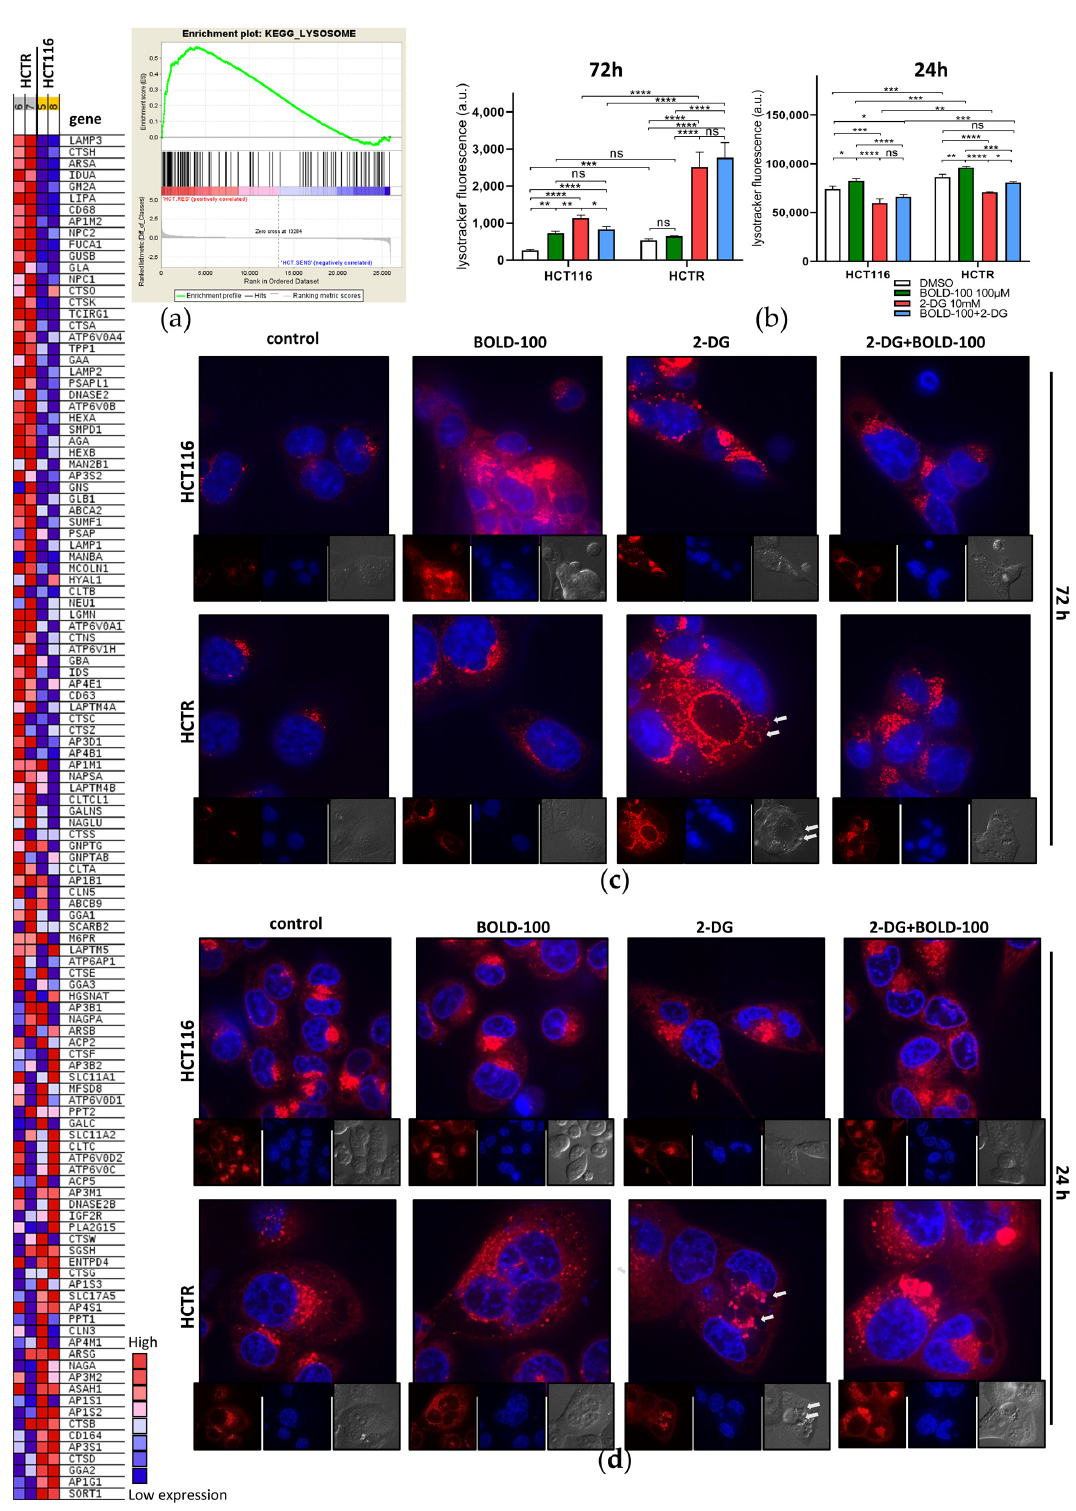
Figure 5. Survival and death from glucose deprivation by 2-DG is associated with differential regulation of the lysosomal compartment. ( a ) GSEA of HCTR vs. HCT116 cells identifies the “LYSOSOME” (nominal p -value < E − 7 ; FDR 0.010) as the fifth most significantly enriched gene set in the KEGG database. The heat map displays differentially regulated genes of the respective gene set. ( b ) Flow cytometry analysis of fluorescence intensity of HCT116 and HCTR cells after 72 h or 24 h